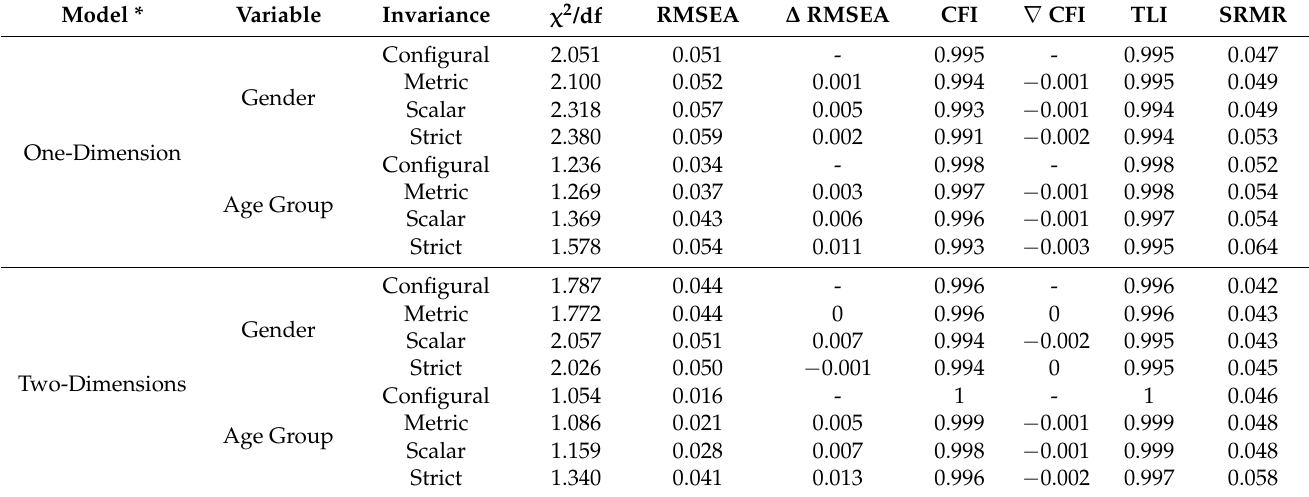
Figure 1. Confirmatory factor analysis path diagrams of the two models proposed: ( A ) One-dimensional model, and ( B ) Two-dimensional model. Standardised weights are presented. Table 4. Goodness of fit indexes for the different steps of the factorial invariance